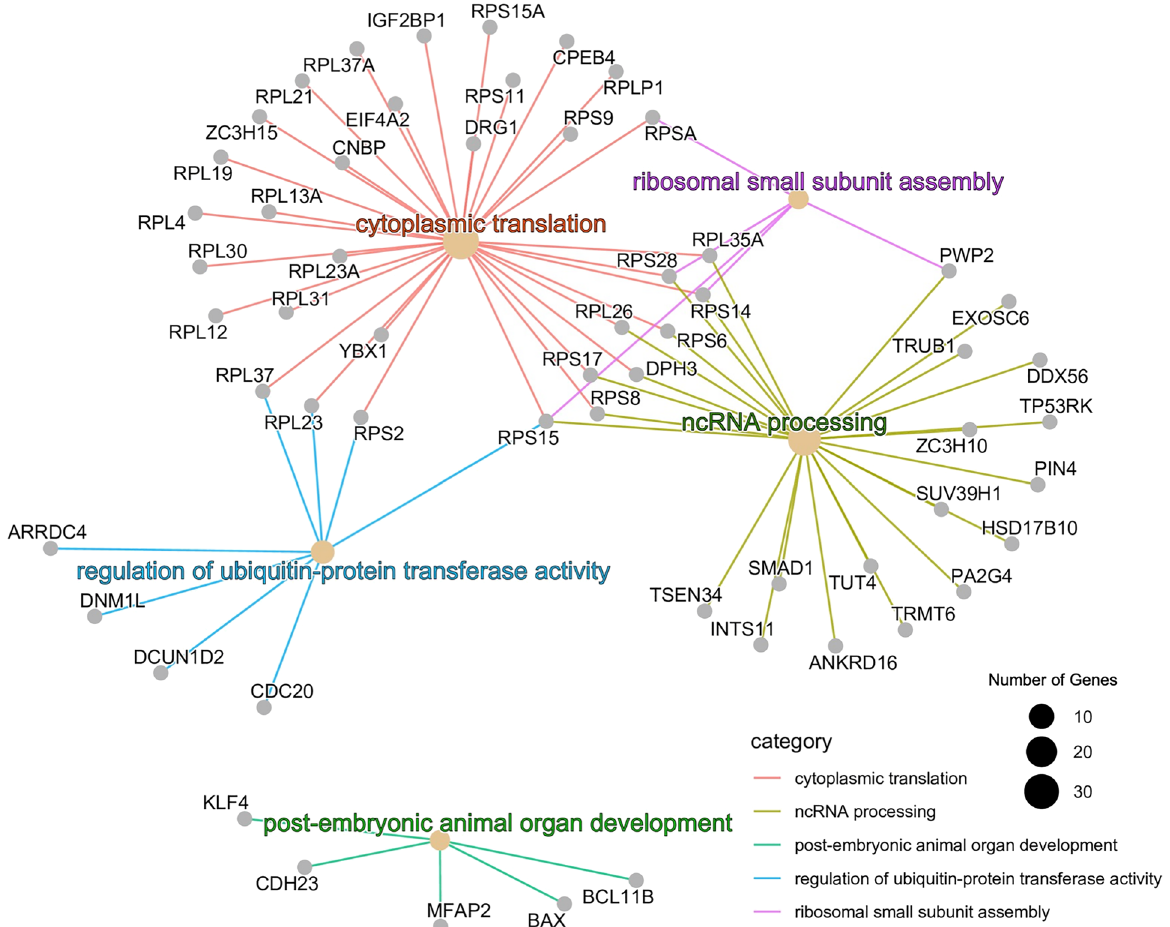
Figure 3. Network diagram of significantly enriched GO biological process terms (adjusted p -value < 0.1) for the human orthologs of Chinese hamster genes detected in Day 0 samples. The small gray nodes show individual genes and larger beige nodes indicate GO terms. The size of the beige nodes is proportional to the number of genes with that GO term and the colored lines indicate the GO category for which a gene belongs